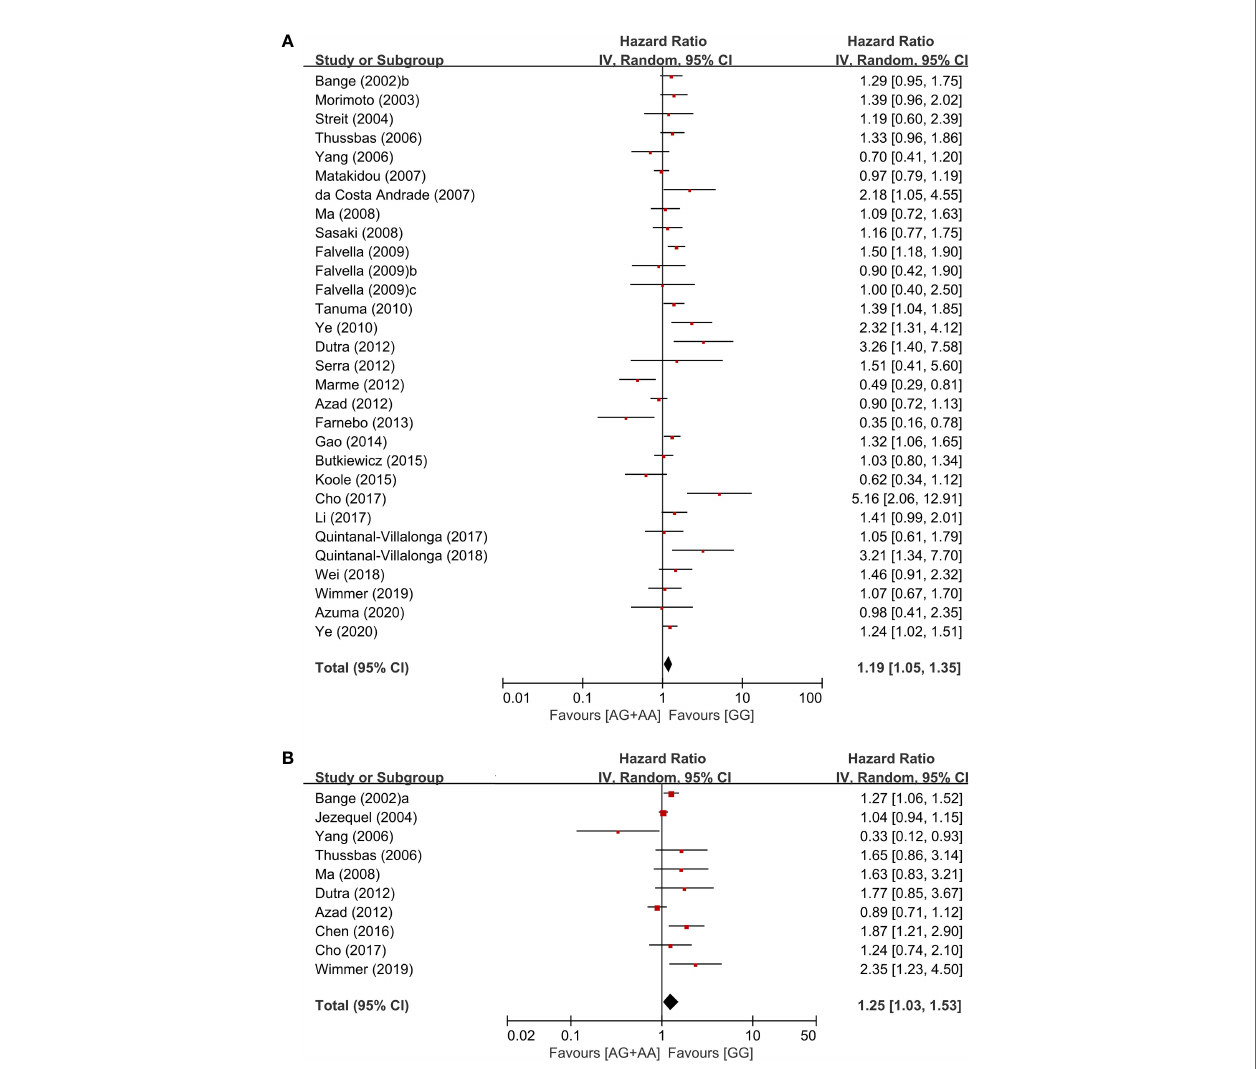
FIGURE 3 | Forest plots for overall survival (A) and disease-free survival (B) in the dominant model (AG+AA vs.